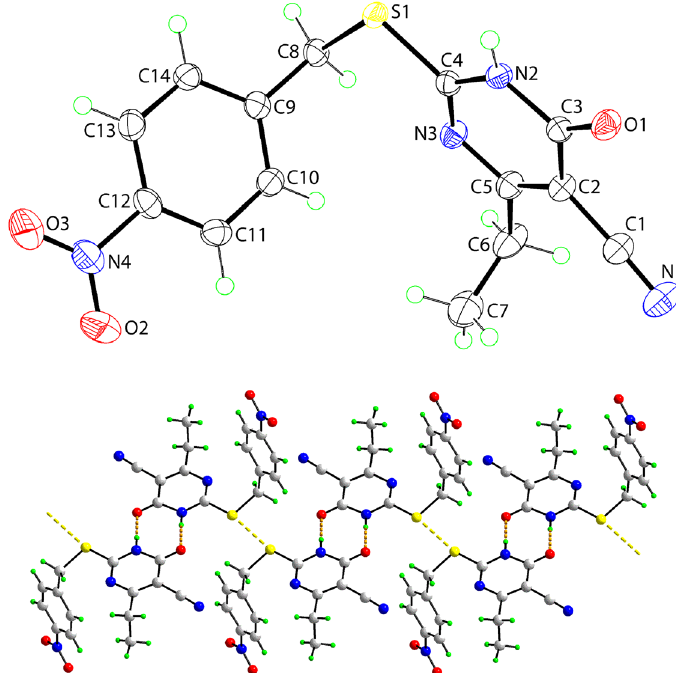
Table  : Data collection and